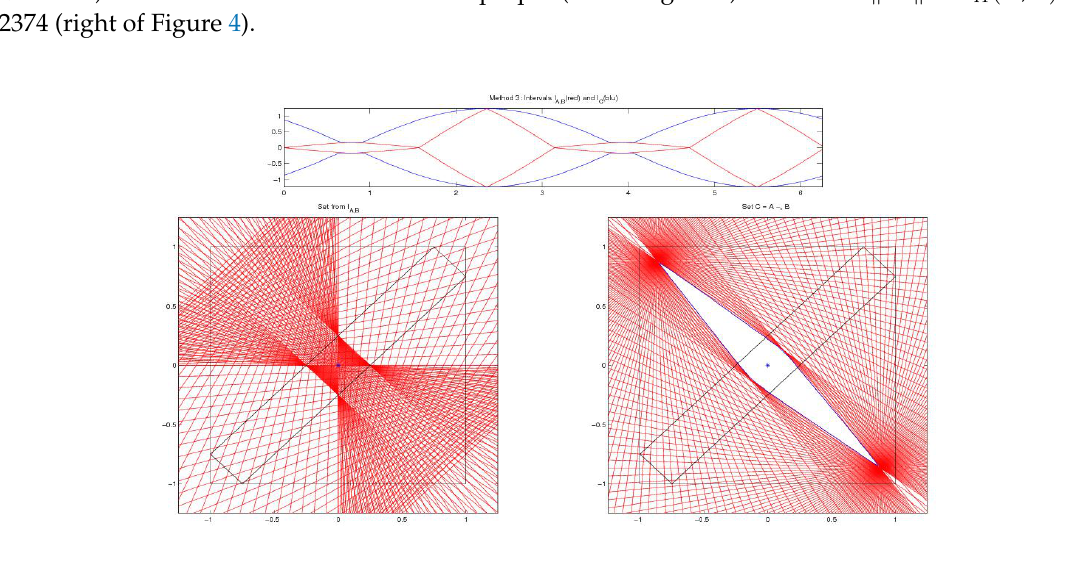
Figure 4. Example 4. g ∗ -difference C ∗ = A (cid:9) ∗ B